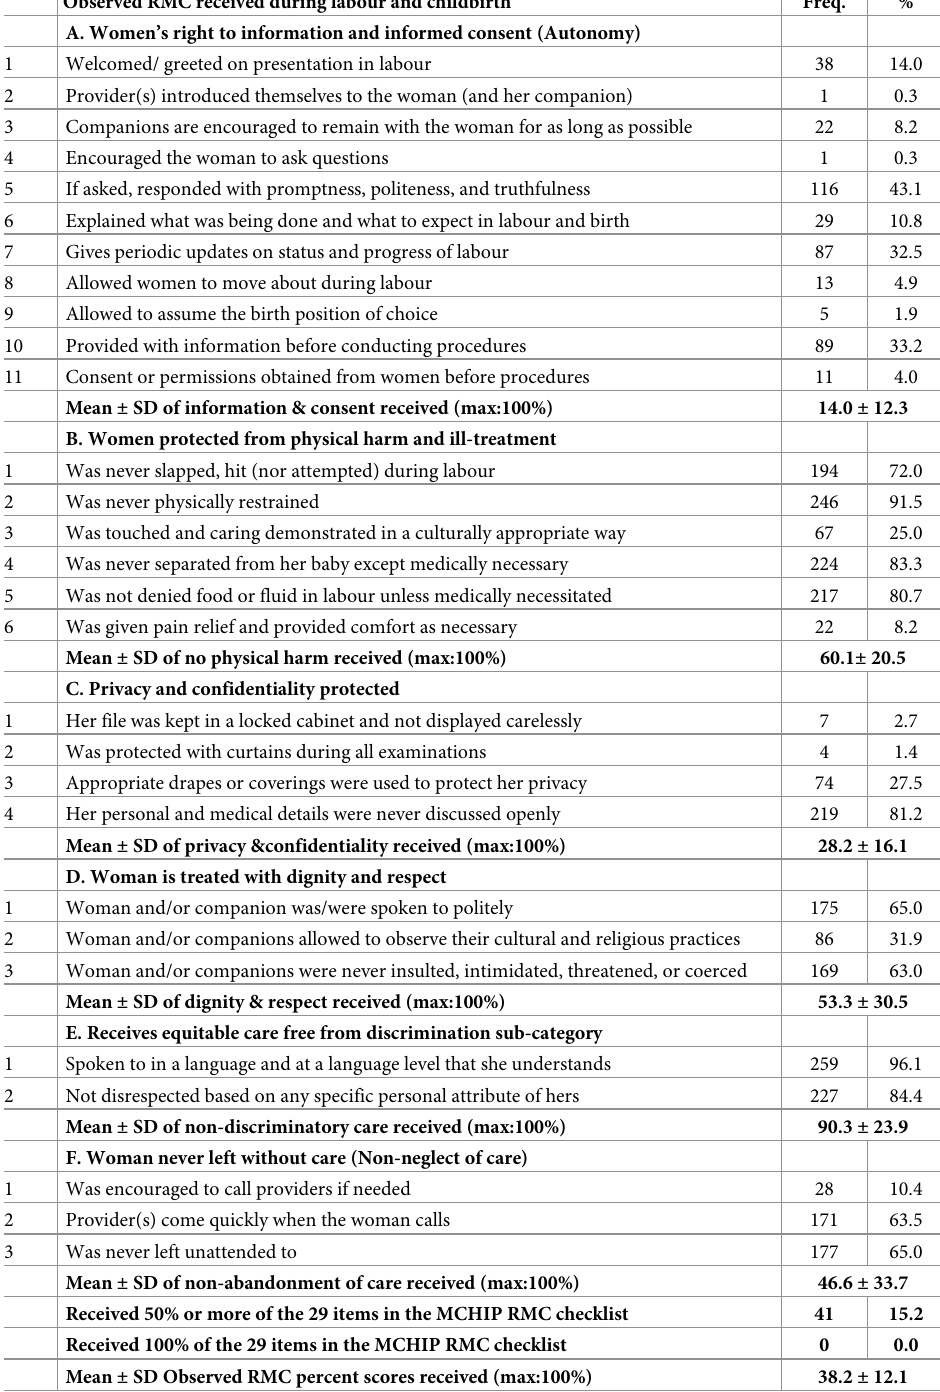
Table 4. Observed RMC items and categories received by women during childbirth (n =